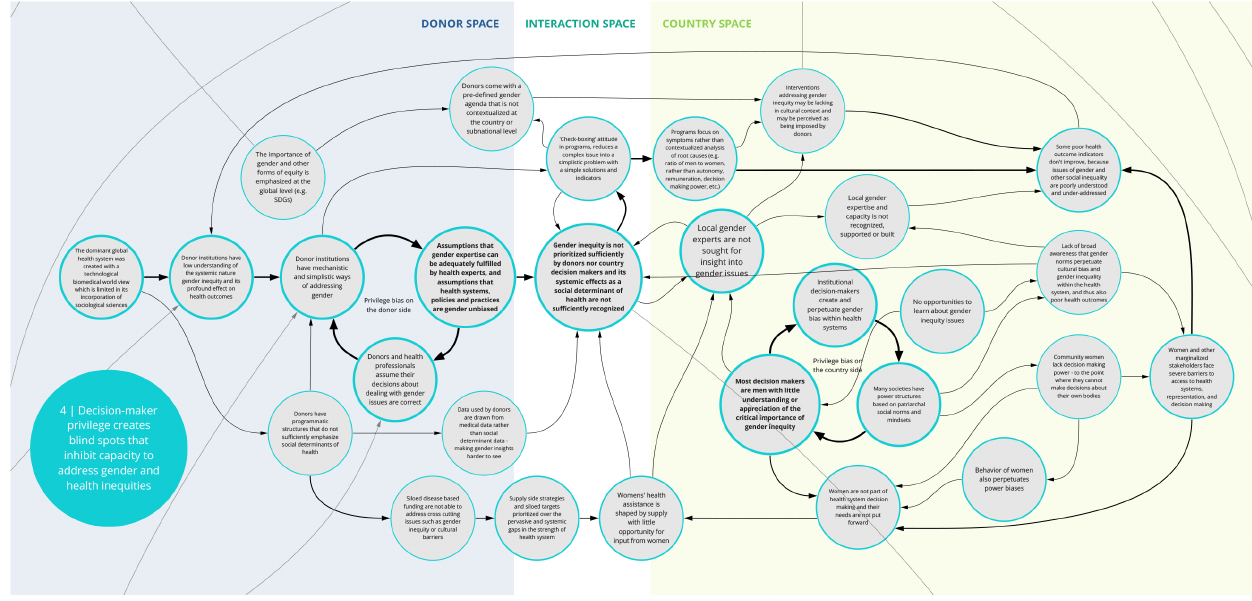
Figure 5. Syndrome 4: Decision-maker privilege creates blind spots that inhibit capacity to address gender and health